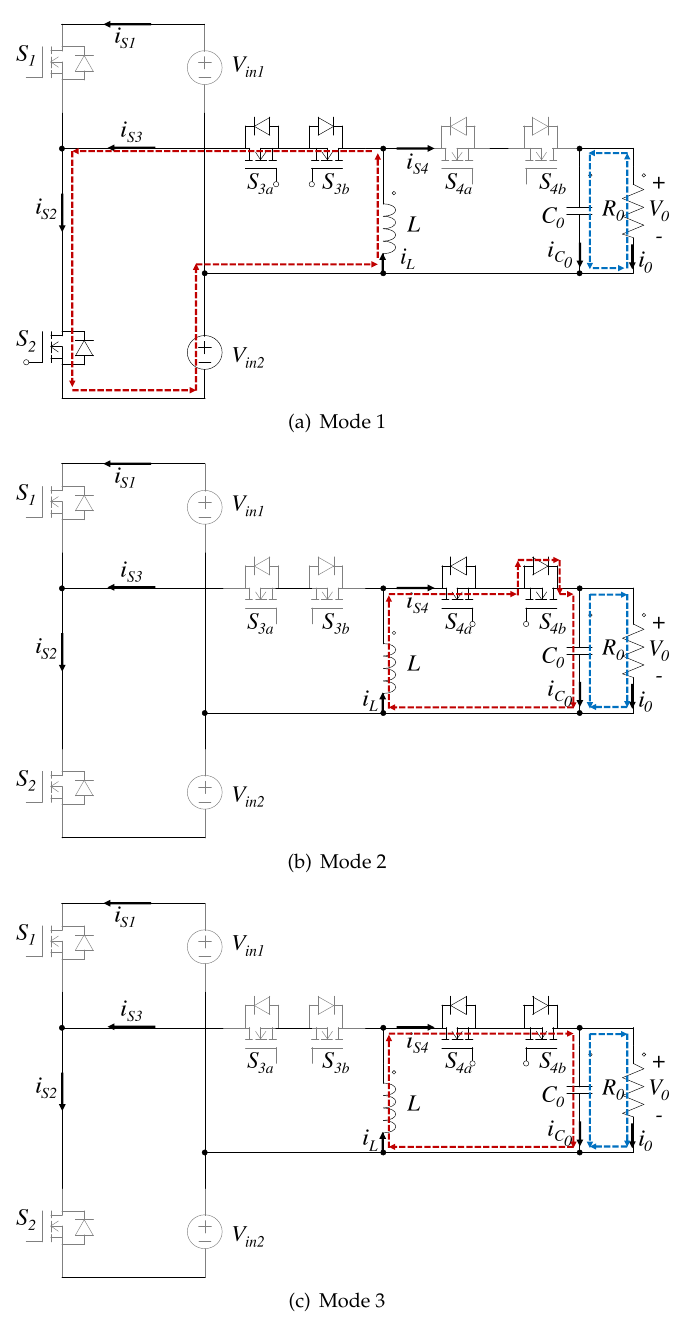
Figure 12. Operational modes of the type-I inverter in Reference